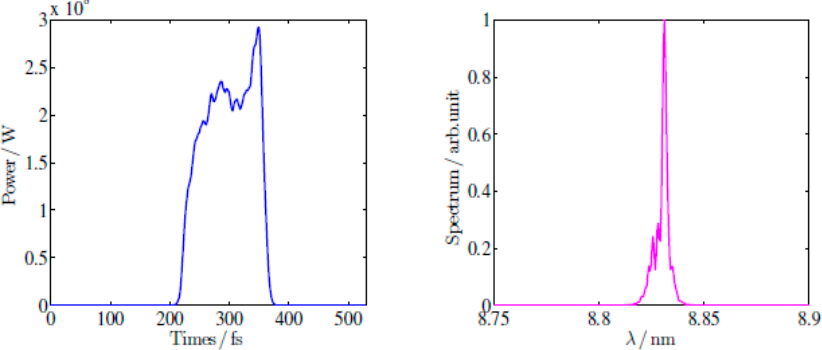
Figure 6. Simulated FEL performances of cascaded high-gain harmonic generation (HGHG) at the SXFEL-TF: final output pulse at 8.8 nm in time ( left ) and spectral ( right ) domain.